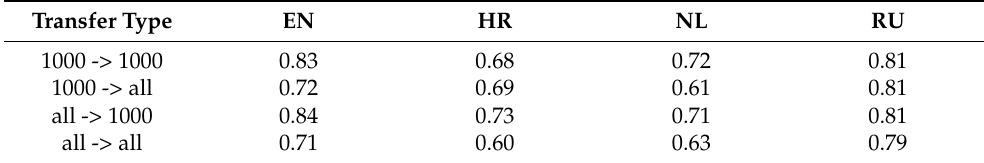
Table A2. Spearman’s correlation coefficients derived by MS-MiniLM model, transfer from German.